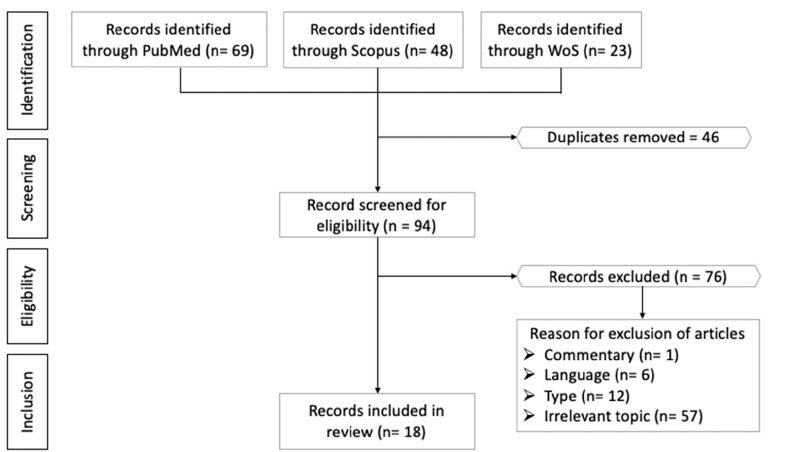
Figure 2. Process of article selection.